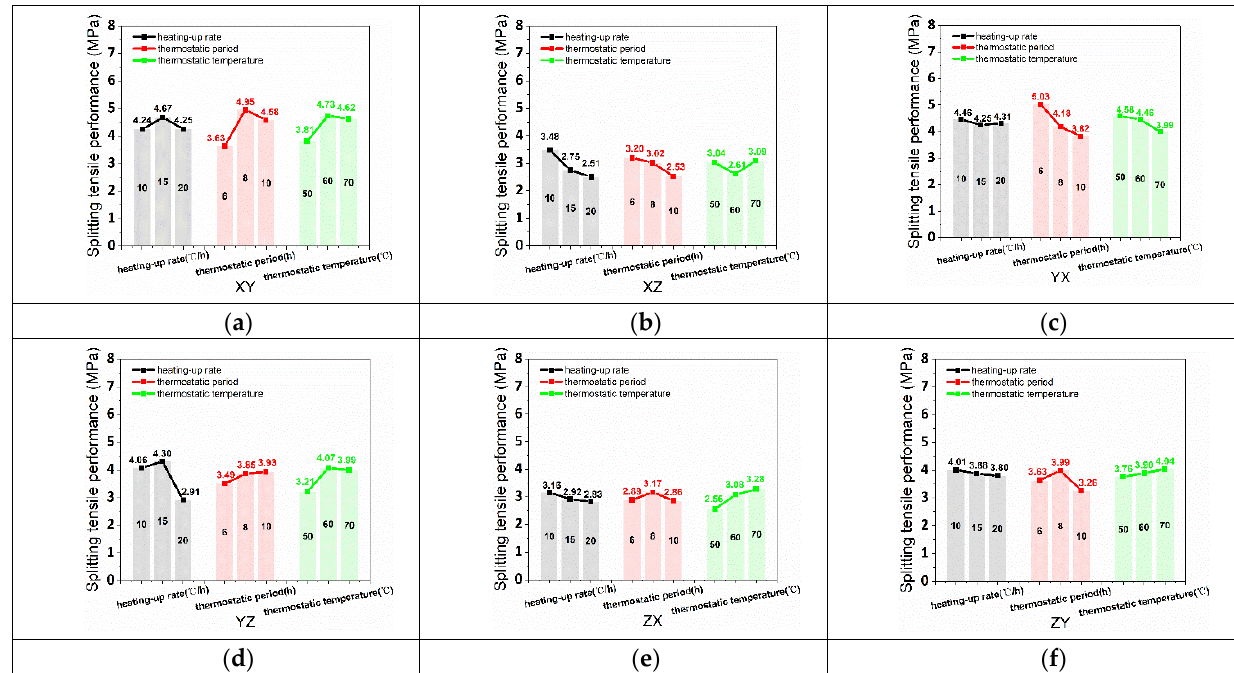
Figure 7. ( a ) TS xy , ( b ) TS xz , ( c ) TS yx , ( d ) TS yz , ( e ) TS zx , and ( f ) TS zy affected by various heating-up rates, thermostatic periods, and thermostatic temperatures.